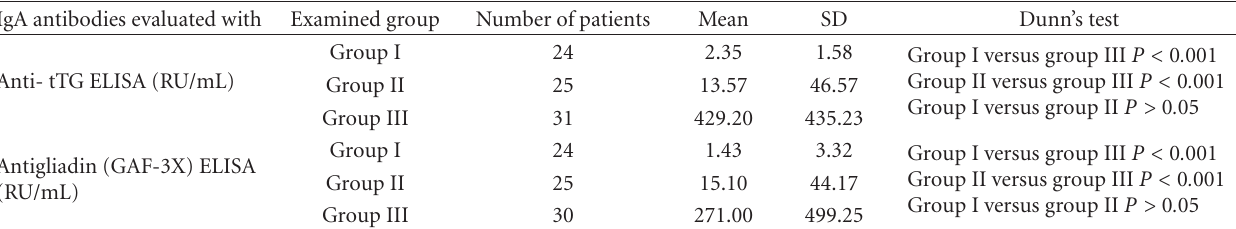
Table 1: Statistical analysis of the three groups of Slavic subjects studied.